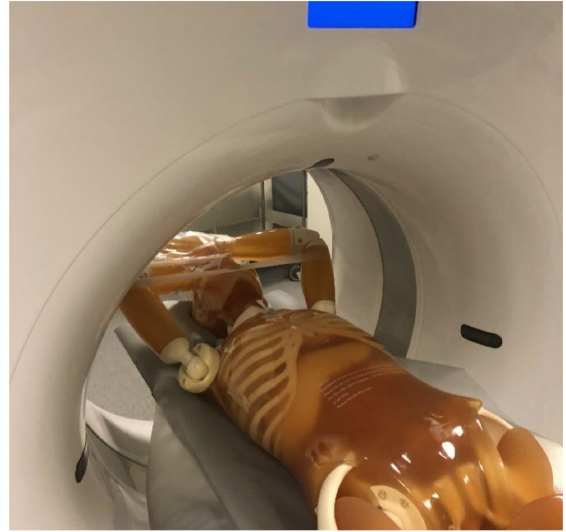
Figure 1. The anthropomorphic whole-body phantom (PBU −